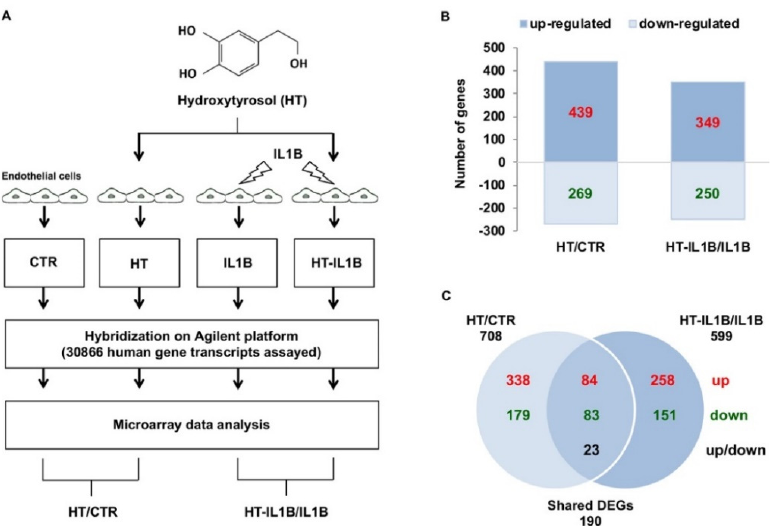
Figure 1. Differentially expressed genes in response to HT treatment in endothelial cells under basal and inflamed conditions. ( A ) Experimental design: HUVECs were treated with 10 µ mol/L HT for 1 h and then stimulated with/without 5 ng/mL IL-1 β for an additional 3 h, after which the total RNA was extracted, and microarray analysis was performed. ( B ) The bar diagram indicates the number of differentially expressed genes (DEGs), which resulted in up-regulated or down-regulated genes in the HT vs. control (HT/CTR) and the HT plus IL-1 β vs. IL-1 β (HT-IL1B/IL1B). ( C ) Venn diagram reporting the numbers of unique and shared DEGs (up-regulated or down-regulated) in HT/CTR and HT-IL1B/IL1B. In red up-regulated DEGs, in green down-regulated DEGs, in black DEGs with opposite regulation (up or